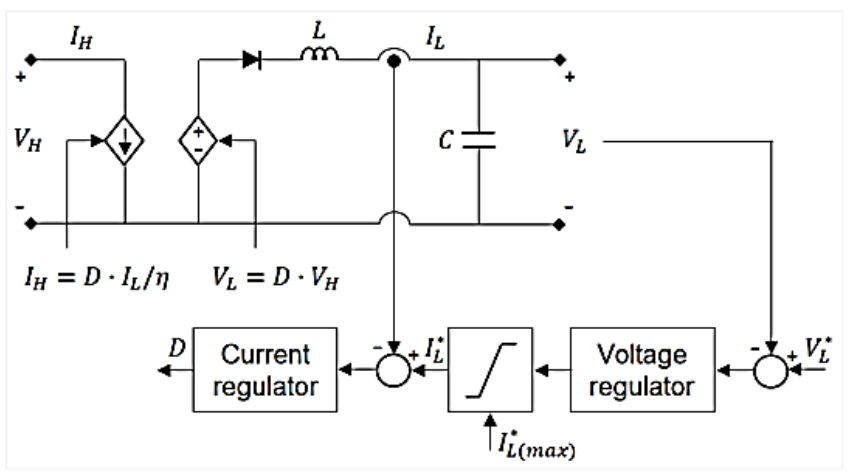
Figure 7. Circuit schematic for converter model.